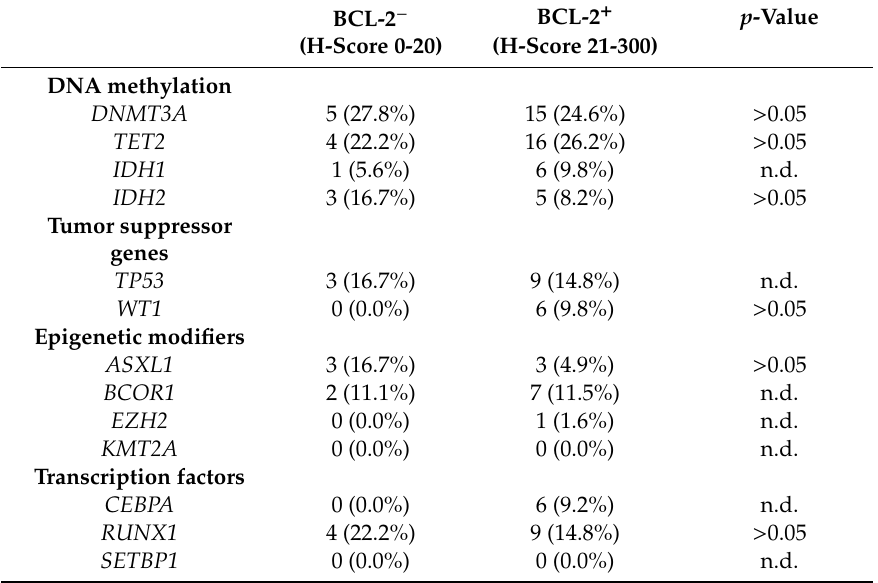
Table 2. Comparison of NGS profiles between the BCL-2 − and BCL-2 + AML subgroups.